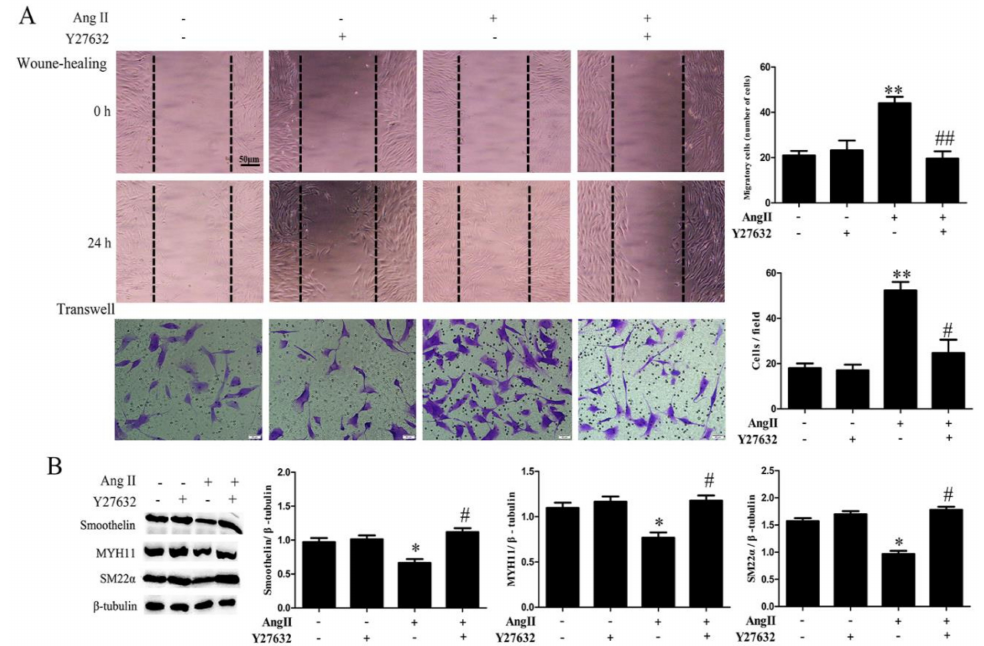
Figure 7. The e ff ects of ROCK inhibitor Y27632 on cell migration and the expression of contractile marker proteins in HA-VSMCs. Cells were pretreated with Y27632 (20 µ M) for 30 min and then exposed to 100 nM Ang II for 24 h. Untreated cells were used as the control. ( A ) Cell migration was detected by wound-healing and Transwell assays. Histograms show the quantification of the wound healing and Transwell assay results. The scar bar is 50 µ m. ** p < 0.01 vs. the control group; # p < 0.05 and ## p < 0.01 vs. the Ang II-treated group ( n = 3). ( B ) Western blot analysis of MYH11, SM22 α , and smoothelin. Histograms show the ratios of MYH11 or SM22 α or smoothelin to β -tubulin. * p < 0.05 vs. the control group; # p < 0.05 vs. the Ang II-treated group ( n =